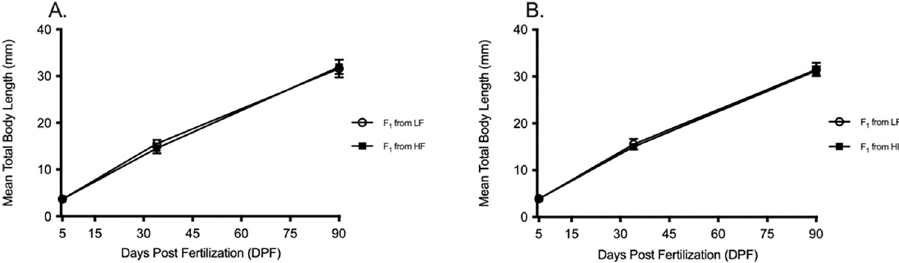
Fig 4. Growth Curves of two F 1 wild-type lines from 5 to 90 DPF. Growth curves for two F 1 generation wildtype lines (offspring of F 0 ), (A) AB and (B) Tu¨ from 5 to 90 DPF. Slow growth curves are represented by mean ± standard deviation. Open circles = LF from F 0 LF parents, closed squares = LF from F 0 HF parents.